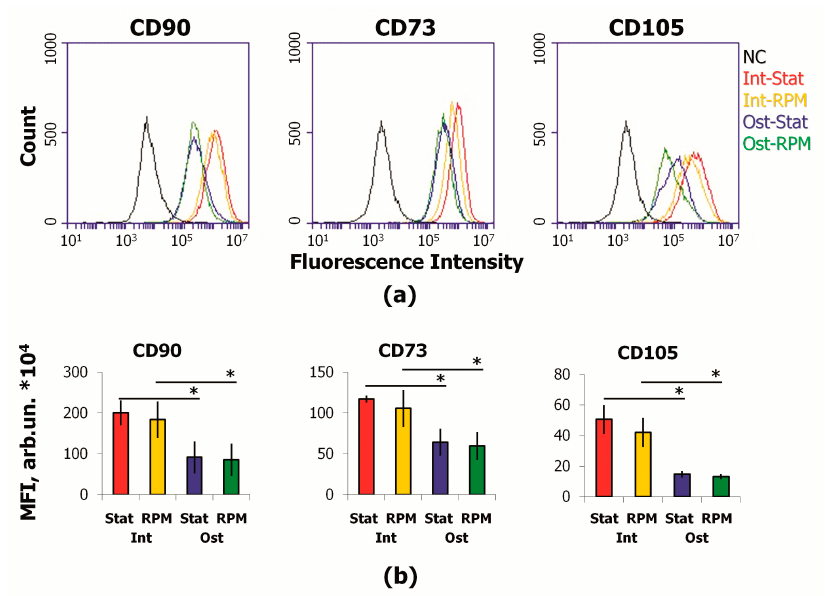
Figure 4. Immunophenotype of MSCs after 10 days of RPM exposure: ( a ) representative fluores- cence plots; ( b ) mean fluorescence intensity (MFI) of CD90, CD73, and CD105. Data are presented as mean ± SD; n ≥ 3, * p < 0.05. MSCs—mesenchymal stromal cells; Int—intact cells; Ost— osteocommitted cells; Stat—static control; RPM—random positioning machine; NC—negative control (MSCs were stained with matched fluorescent nonimmune antibody).